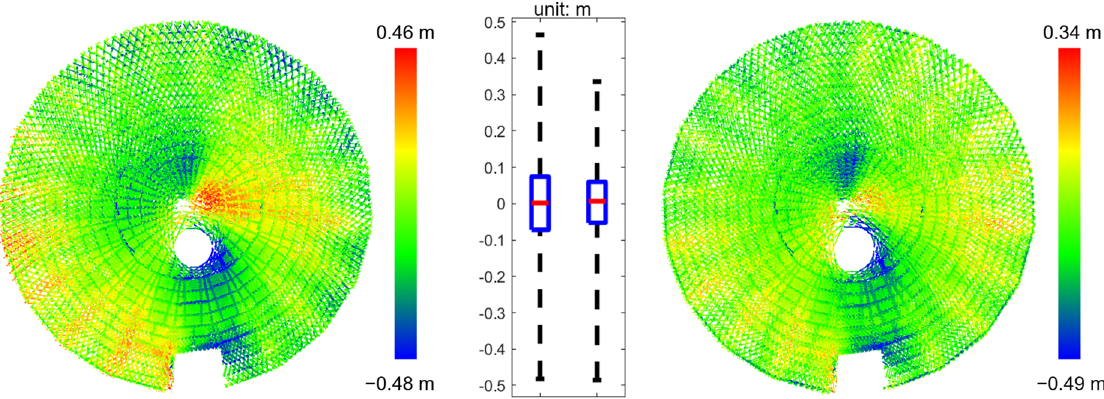
Figure 32. Heat maps and box plots representing the normal distance between the roof feature points and fitted quadratic surface for the Frankfort dataset before (left) and after (right) partial fine registration.